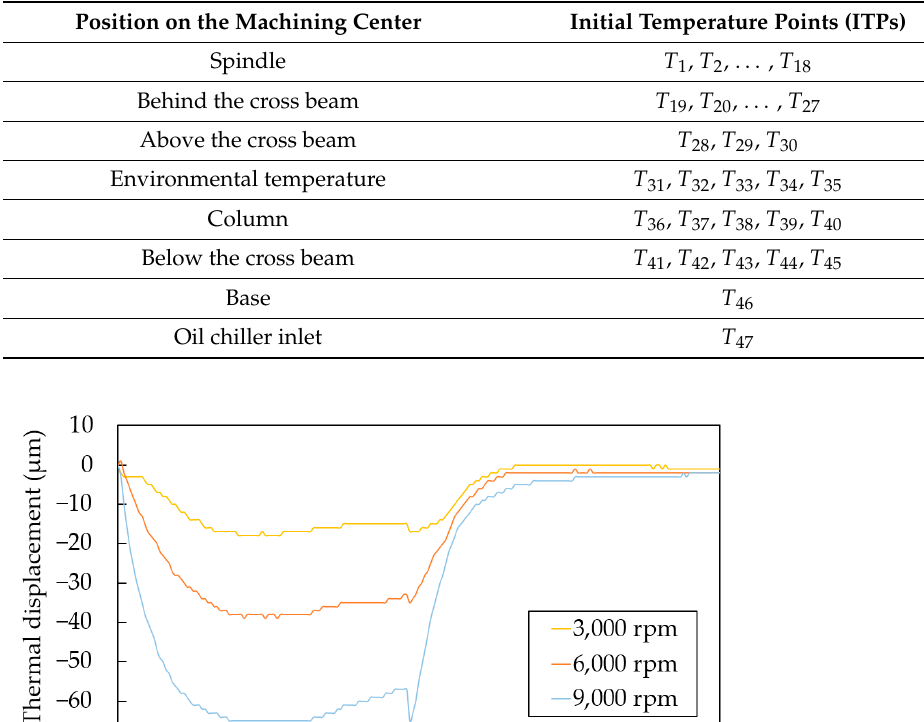
Figure 4. Positions of the 47 ITPs for AWEA VP-2012 (Hsinchu, Taiwan). Table 1. Description of the ITPs corresponding to machine structure positions.